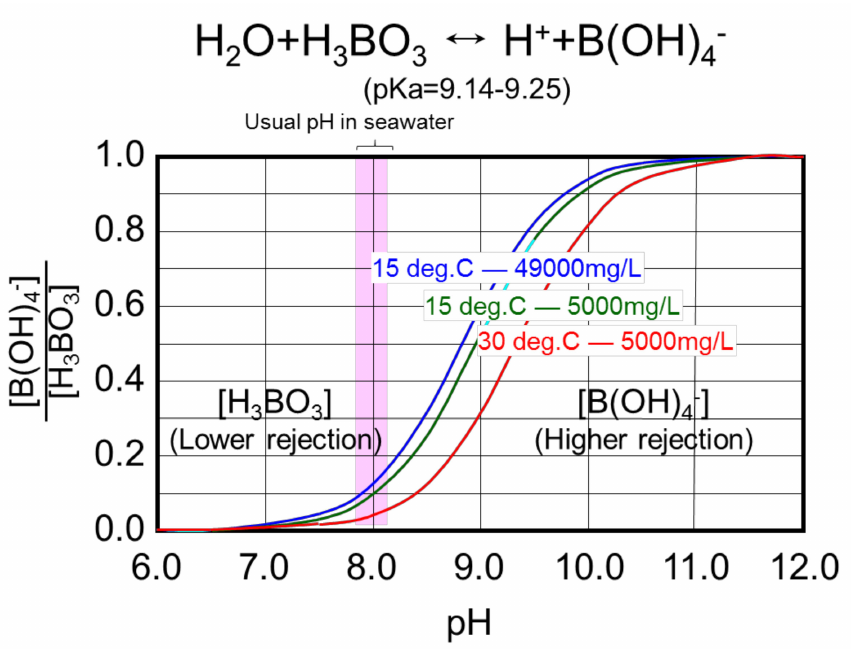
Figure 6. The boron dissociative equilibrium. Higher pH raises the ratio of B(OH) 4 − , which enhances rejection due to the electric repulsion effect of the RO membrane